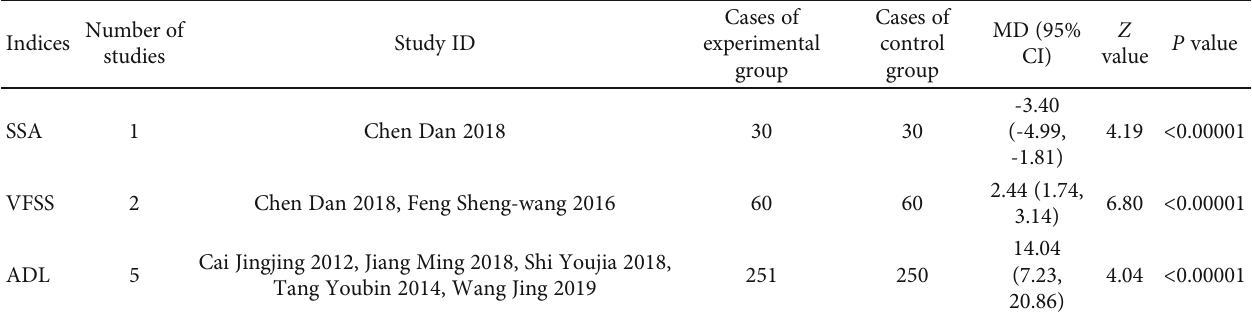
Table 9: ACU combined with routine treatment vs. routine treatment on the swallowing function score.